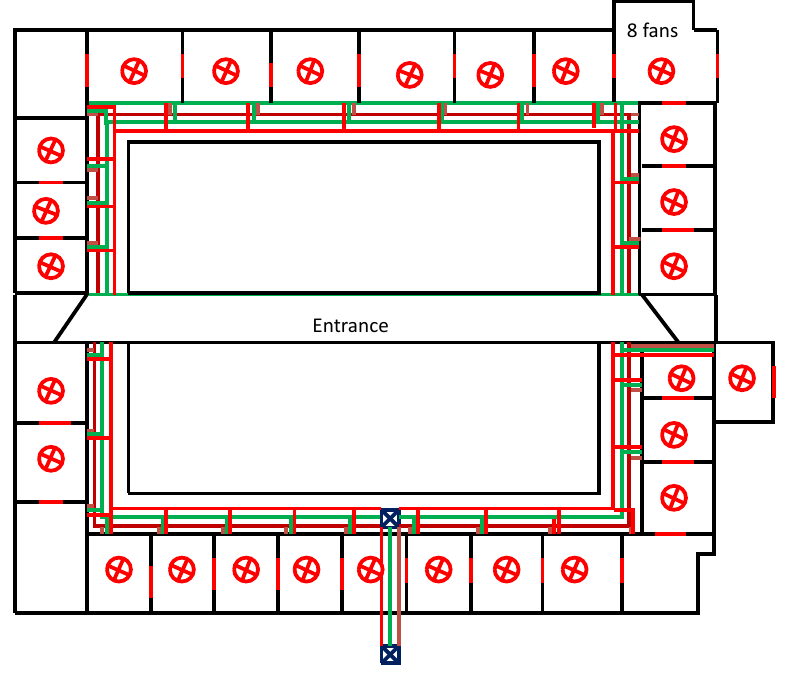
Figure 11. Rahman Baba Hostel wiring.